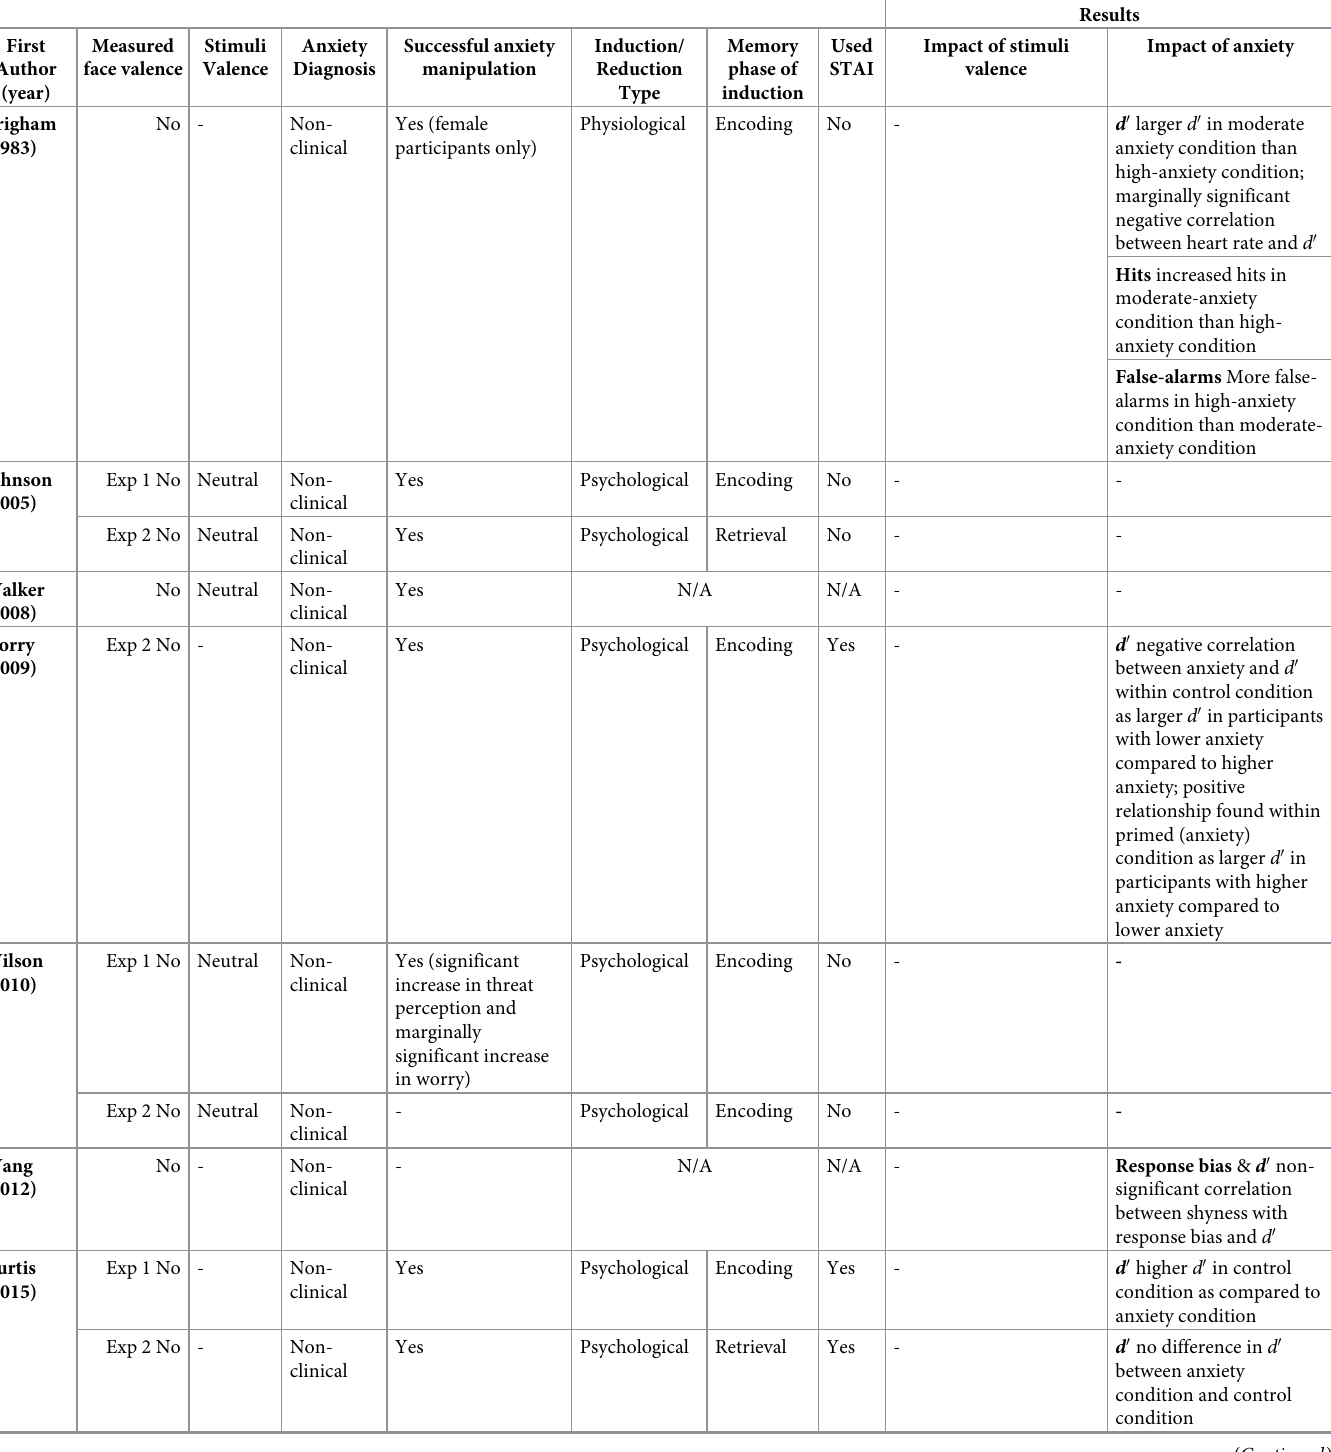
Table 3. Influence of face-stimuli valence and anxiety on face-recognition accuracy, and stage of memory anxiety induced (encoding or retrieval), for included